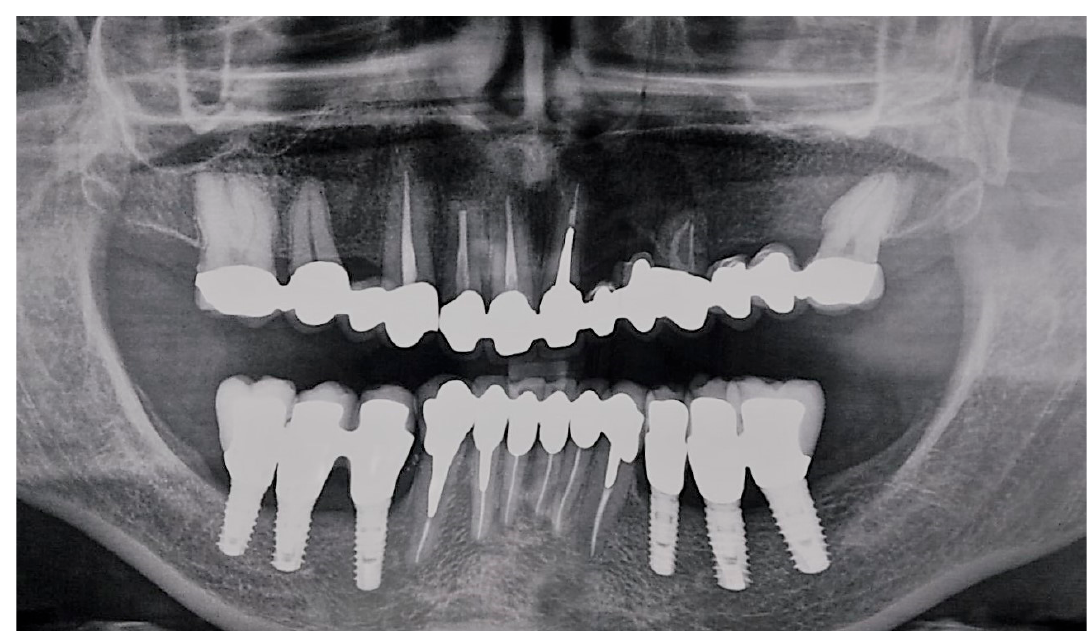
Figure 5. Twelve month follow-up: Orthopantomography.